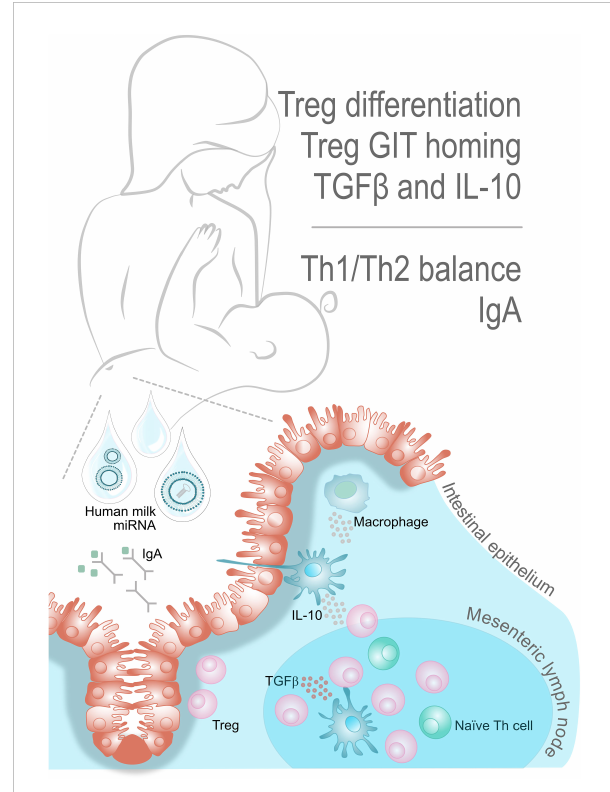
FIGURE 1 Key players in oral tolerance. Oral tolerance is an active suppression of cellular and humoral responses to antigens. The mesenteric lymph node is the major site for Treg cell differentiation, as mediated by CD103+ DCs. Production of the anti-in fl ammatory cytokines IL-10 and TGF- b supports the positive feedback loop of stimulating CD103+ DCs, Tregs and tolerogenic macrophages. The TGF- b also promotes B cell antibody class switching towards IgA, thus facilitating antigen exclusion in the intestinal lumen. Interestingly, there seems to exist several breastmilk miRNAs with potential involvement in these